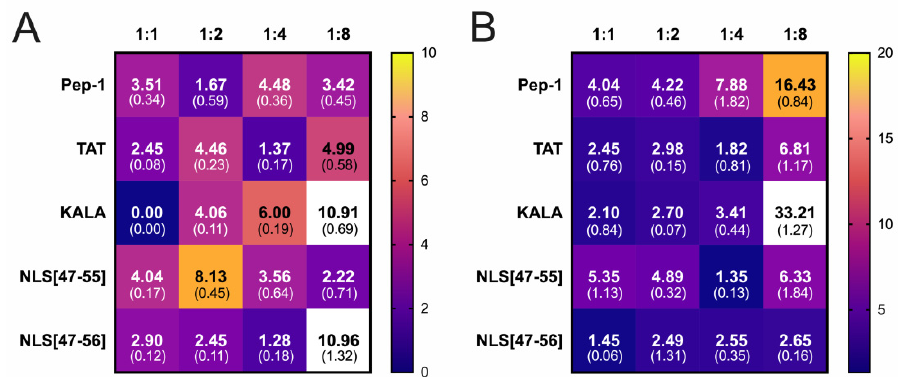
Figure 8. Results of 24 h culture in the presence of complexes in CRs of 1:1, 1:2, 1:4 and 1:8. The complexes were formed using incubation of 2 μ g pmaxGFP with chosen CPPs at 37 °C for 15 min. Bar = 50 μ m. CR, charge ratio.